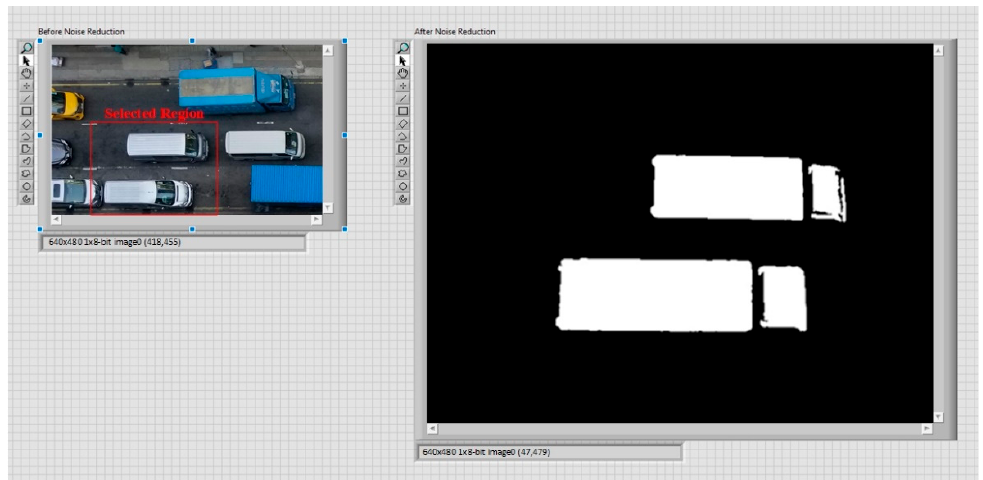
Figure 12. Image differences before and after noise reduction. Figure 12. Image di ff erences before and after noise